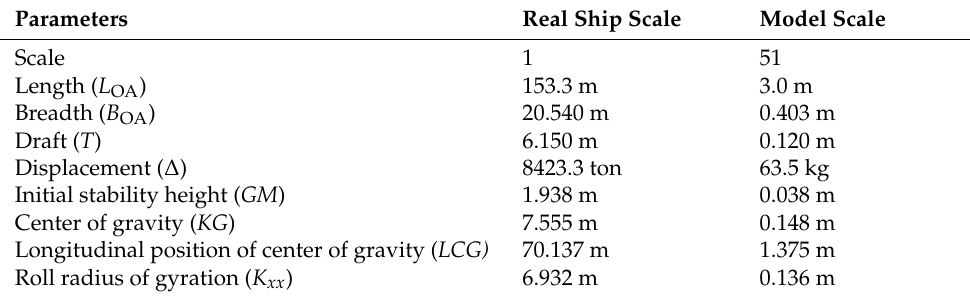
Figure 2. Geometry of the ship model. Table 1. The main geometry parameters of the DTMB-5415